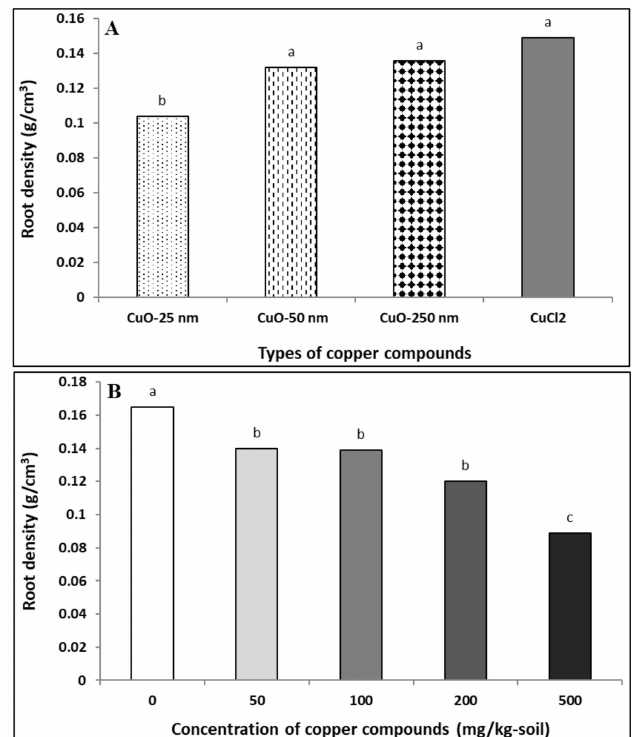
Figure 3. E ff ect of copper compound types ( A ) and concentrations ( B ) on soybean root density. The data for ( B ) are the aggregates of root density for all CuONPs and Cu 2 + ions combined as they were not significantly di ff erent at the same concentration treatment. Same letter above the bars indicates no significant di ff erence between the treatments according to the Fisher’s LSD test ( p ≤